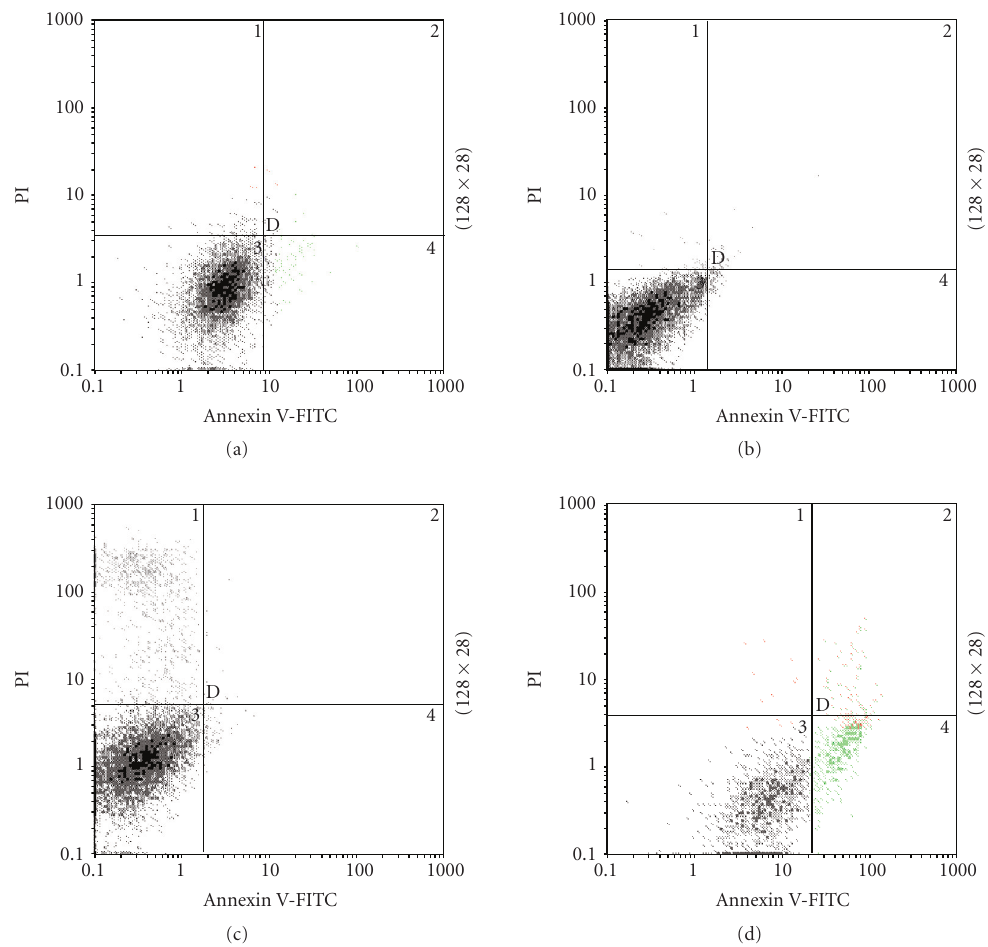
Figure 6: Flow cytometric determination of apoptosis. (a) Unstained normal MCF-7 cells (b) EP3-transfected cells stained with both PI and Annexin V-FITC (c) ET-transfected cells stained with both PI and Annexin V-FITC (d) Cisplatin-treated cells stained with both PI and Annexin V-FITC. Note that some cells transfected with PT were dead as a result of high cell density. Results are representative of two